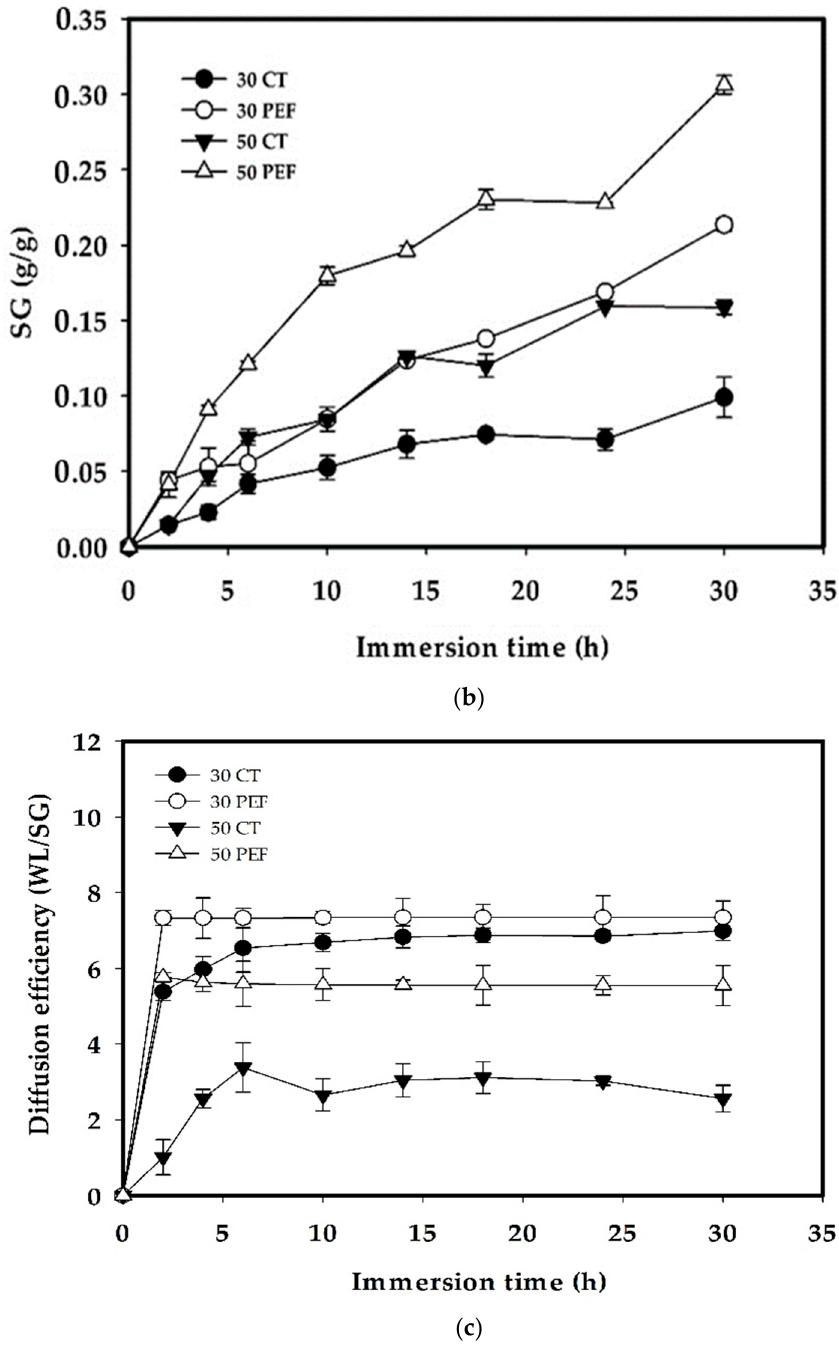
Figure 2. Time course of the mango pickles: ( a ) water loss (WL) and ( b ) solids gain (SG), and ( c ) diffusion efficiency (DE) for conventional pickling at 30 ◦ Brix ( • ) and 50 ◦ Brix ( (cid:72) ), and PEF-assisted pickling at 30 ◦ Brix ( ) and 50 ◦ Brix ( (cid:52) (cid:35)